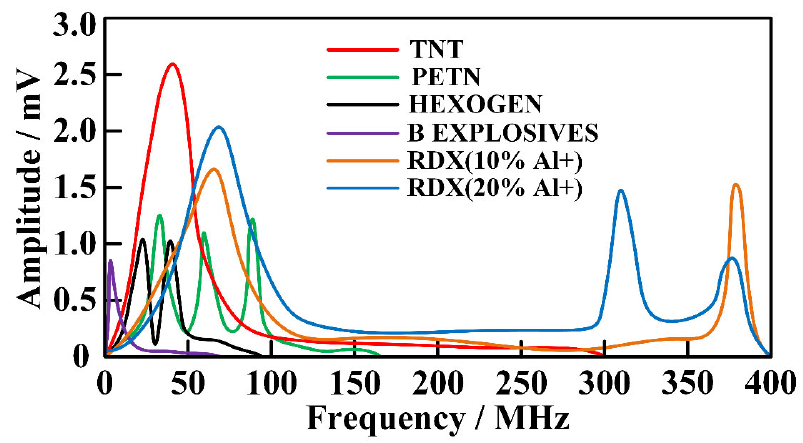
Figure 7. Electromagnetic radiation spectrum of different explosives.